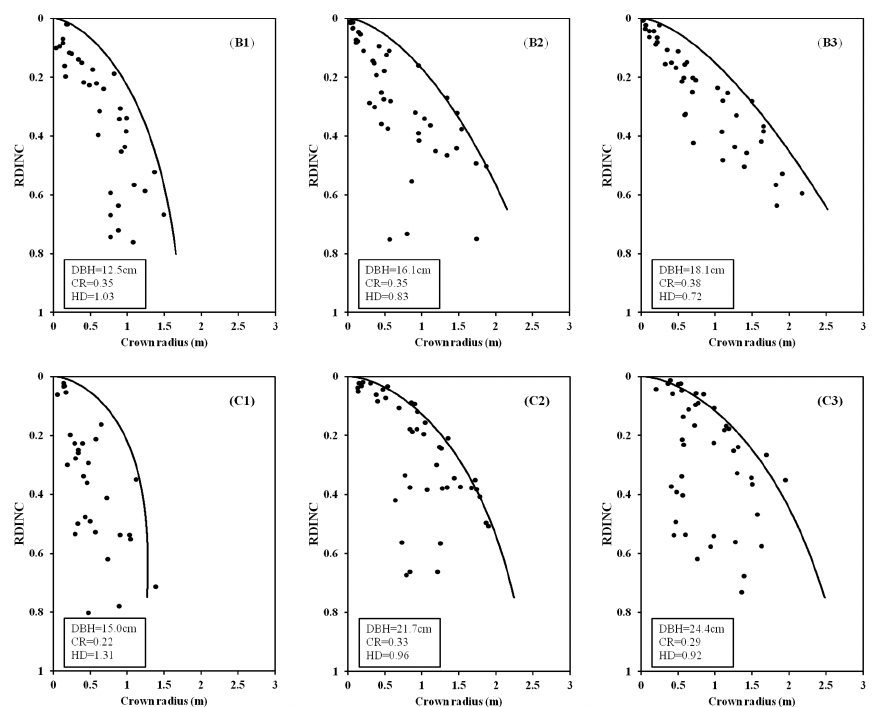
Figure 4. The fitted outer crown profiles against the observed crown radius for three sample trees from three same plots (stand age is 20 years and stand density is 3950 trees ha − 1 for tree ( A1 – A3 ); stand age is 33 years and stand density is 1883 trees ha − 1 for trees ( B1 – B3 ); stand age is 44 years and stand density is 1640 trees ha − 1 for trees ( C1 – C3 )) for the planted Pinus sylvestris var. mongolica